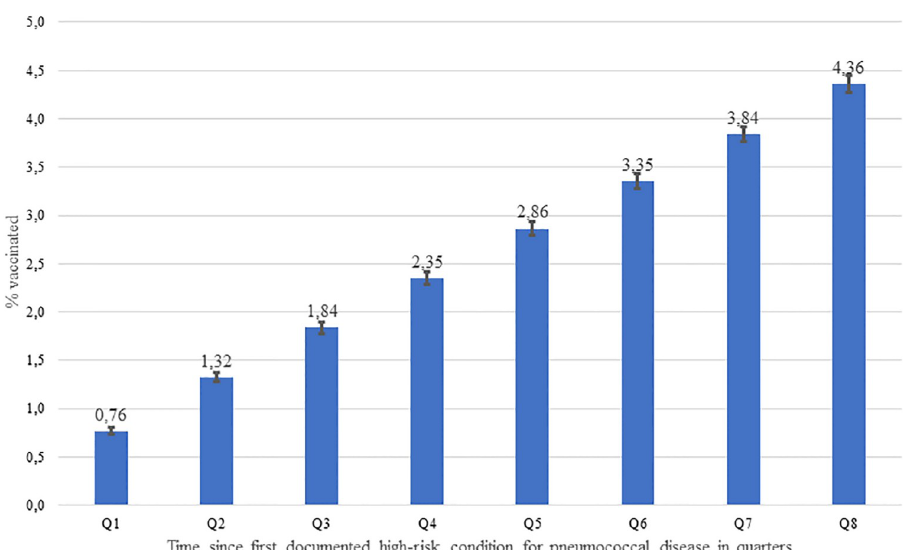
Fig 2. Cumulative pneumococcal vaccination rate within eight quarters after first documented “high-risk” condition for pneumococcal disease.